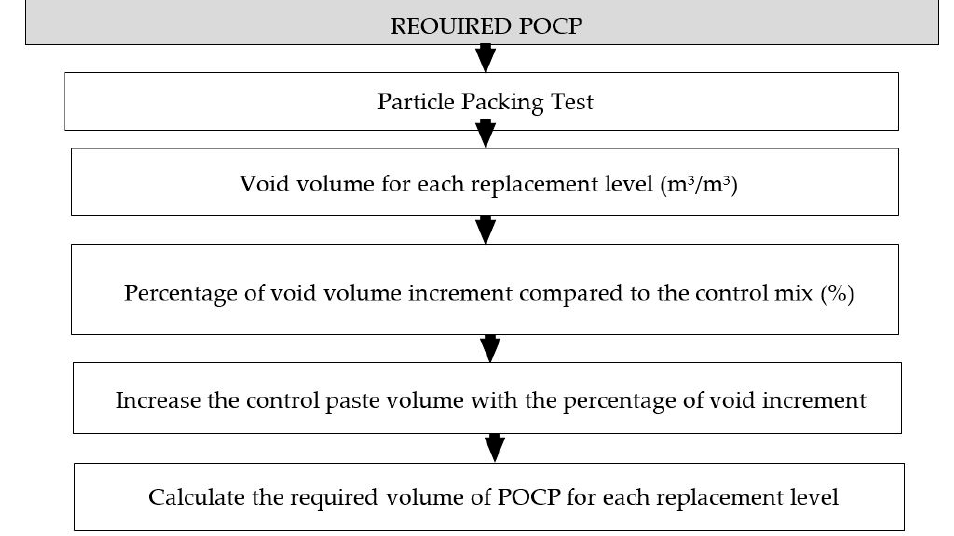
Figure 6. Flow chart to determine the required POCP.